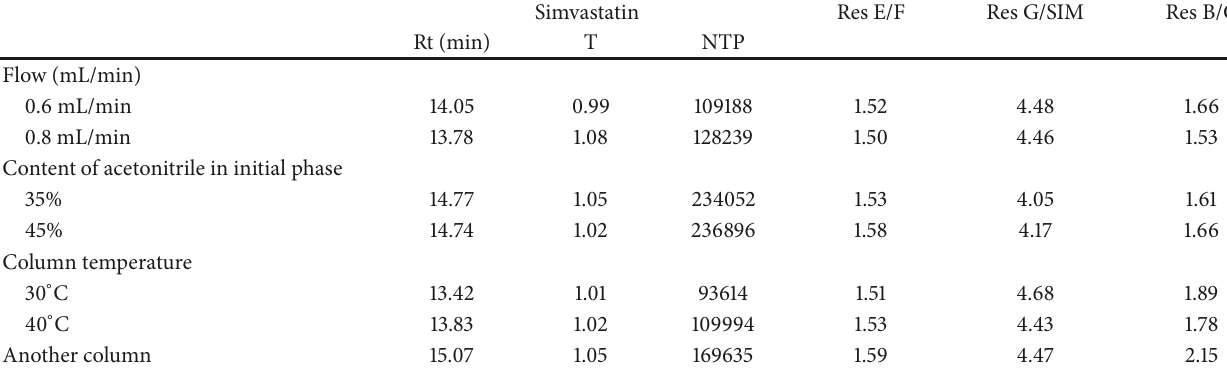
Table 5: Obtained results from validation of the proposed method :